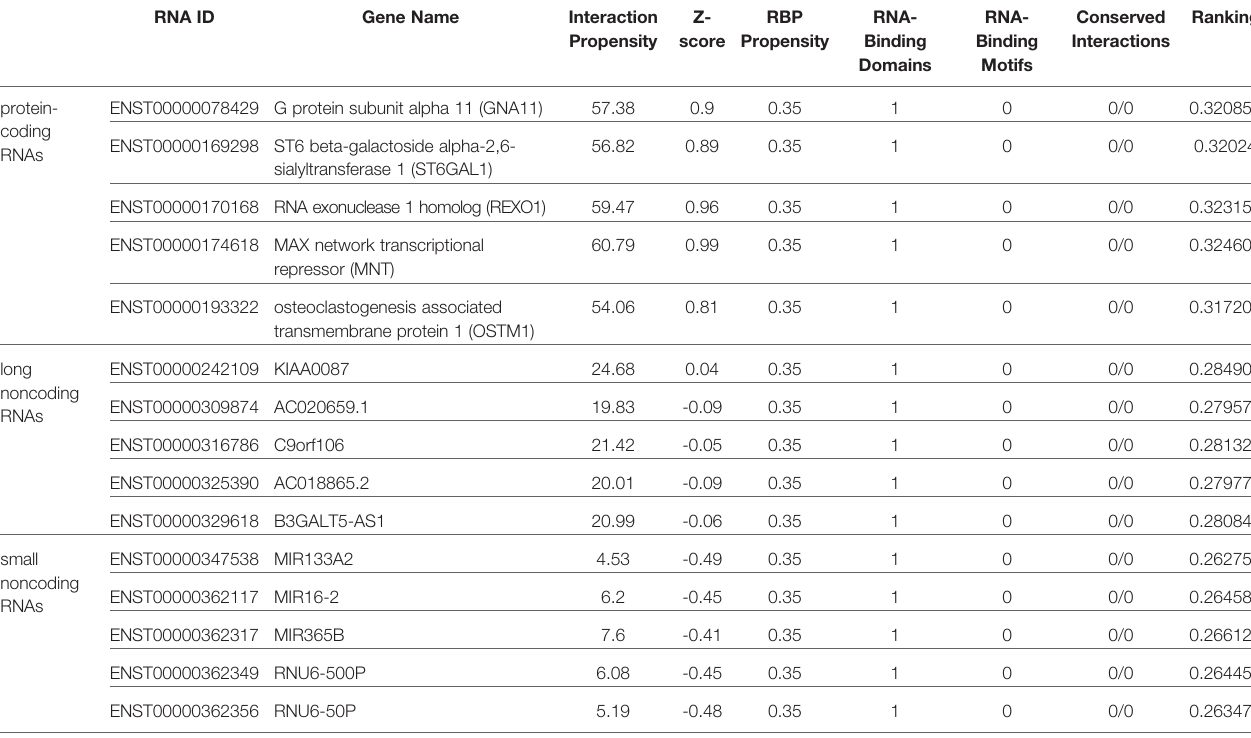
Table summarization of the top 5 predicted coding-RNA interactors (RNA ID and Gene Name) of murine-cGAS by catRAPID omics (version 2.0). The table shows Z-scores (interaction propensity normalization relative to experimental cases), discriminative ability (relative to training sets), interaction strength (enrichment relative to random interactions), the presence of RNA-binding domains, and RNA motifs. RNAs were ranked by the score, which is the sum of three individual values: 1) catRAPID normalized propensity, 2) RBP propensity and 3) presence of known RNA-binding motifs. The full score is